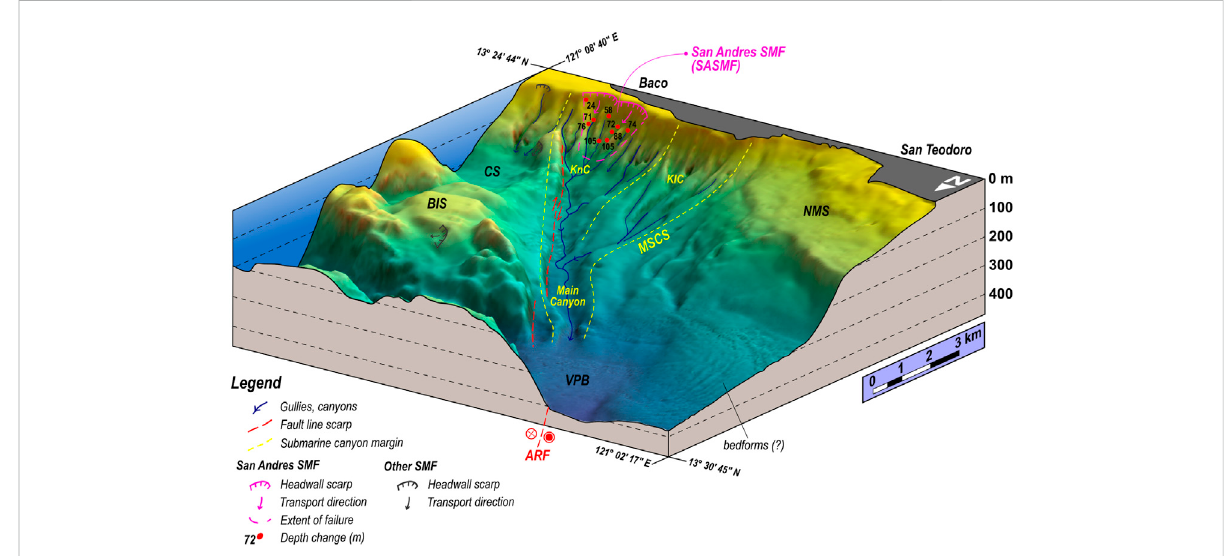
FIGURE 5 Three-dimensional view of the offshore Aglubang River Fault and the Malaylay Submarine Canyon System (MSCS). The red dots show the location of depth comparisons with the thickness of eroded material in meters. KnC = Kanan Submarine Canyon; KlC = Kaliwa Submarine